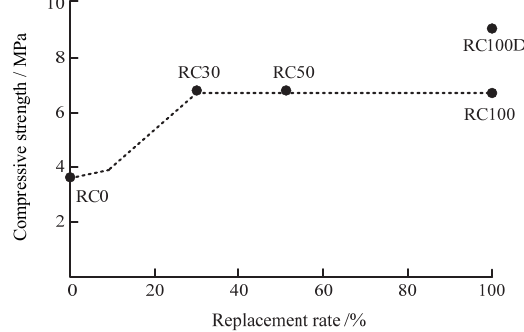
Figure 3: Compressive strength of the recycled pervious concrete.